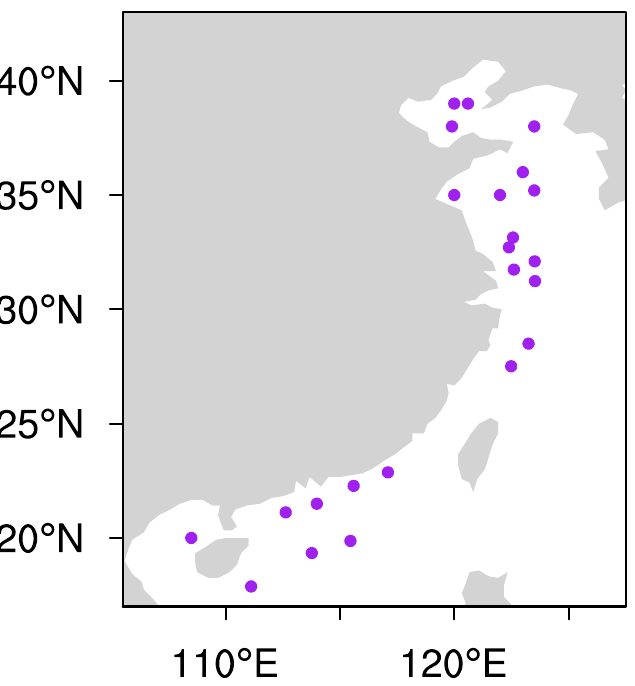
Figure 1. Positions of the buoys in China’s offshore waters, where purple dots indicate the buoys ‘